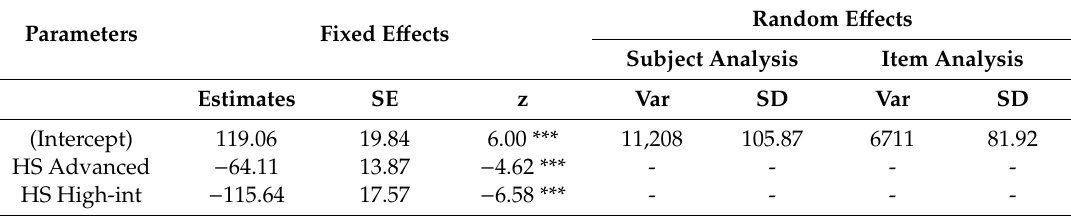
Table 6. Summary of the fixed e ff ects and random e ff ects in the generalized linear mixed-e ff ects model (for the question SFP ba ).